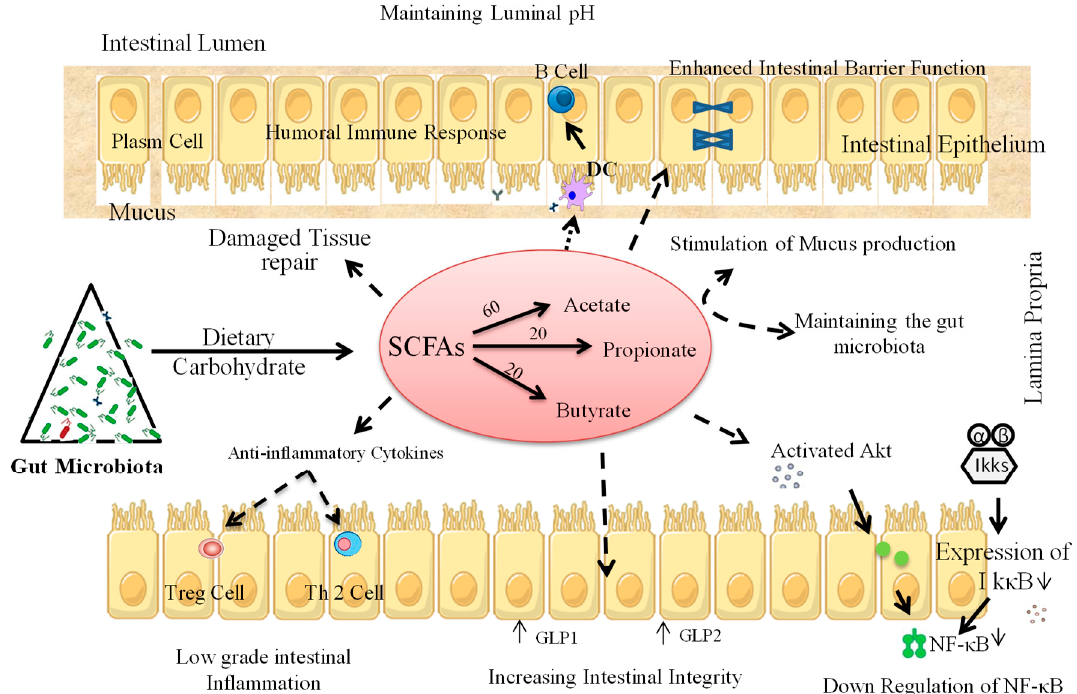
Figure 4. Purported mechanism(s) of action through which prebiotics could manipulate gut microbiota as well as immune cells of T1D pathology. Akt: protein kinase B; DC: dendritic cell; GLP-1: glucagon-like peptide-1; GLP-2: glucagon-like peptide-2; IkkB: I κ B kinase beta; I κ B α : I kappa B kinase; NF- κ B: Nuclear factor kappa-light-chain-enhancer of activated B-cells; SCFAs: short chain fatty acids; Th2: T-helper cell 2; Treg: T regulatory cell.